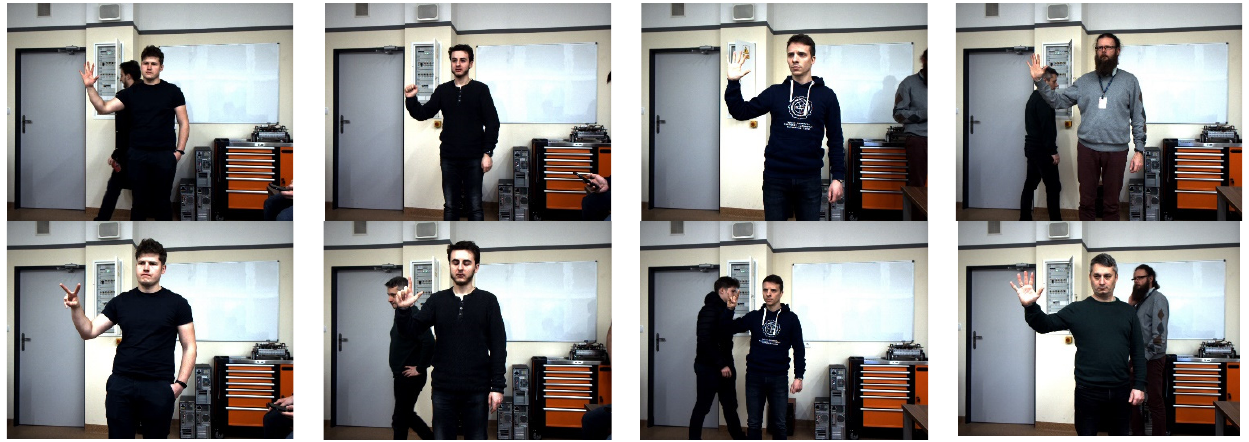
Figure 2. Sample raw 2D images taken during experiments.